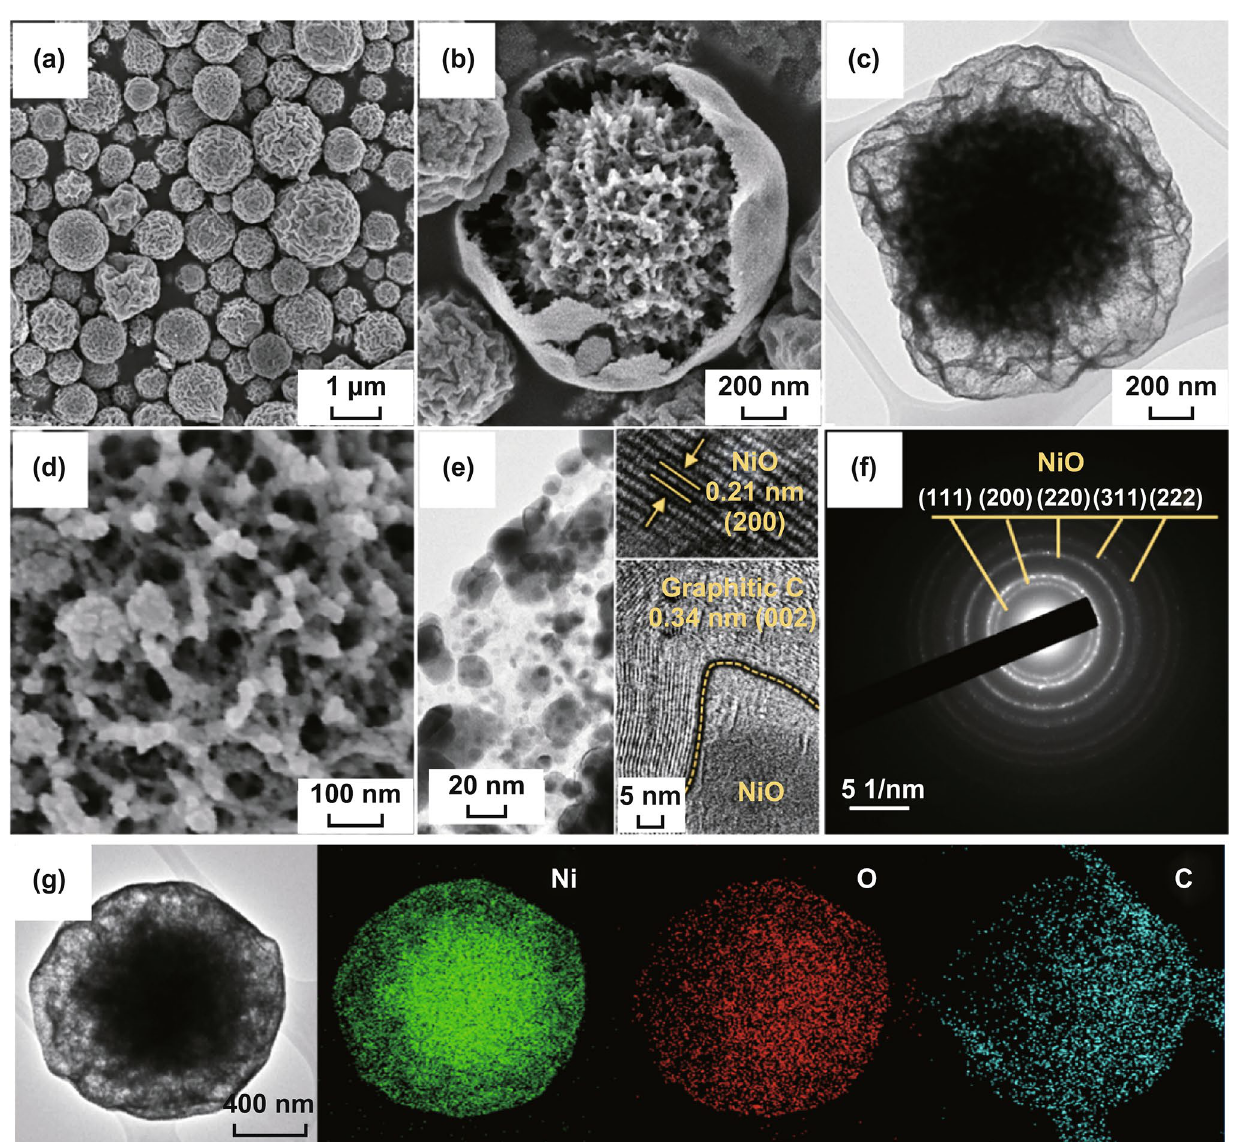
Fig. 5 a , b , d FE‑SEM images, c , e HR‑TEM images, f SAED pattern, and g elemental mapping images of the CYS‑NiO/C